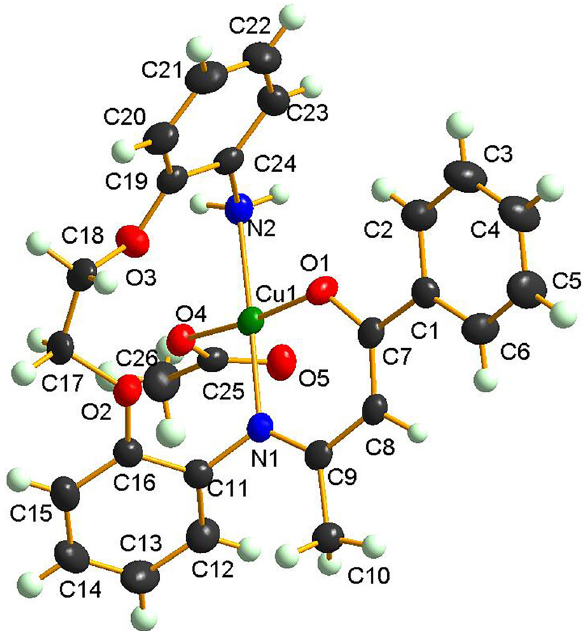
Table  : Data collection and